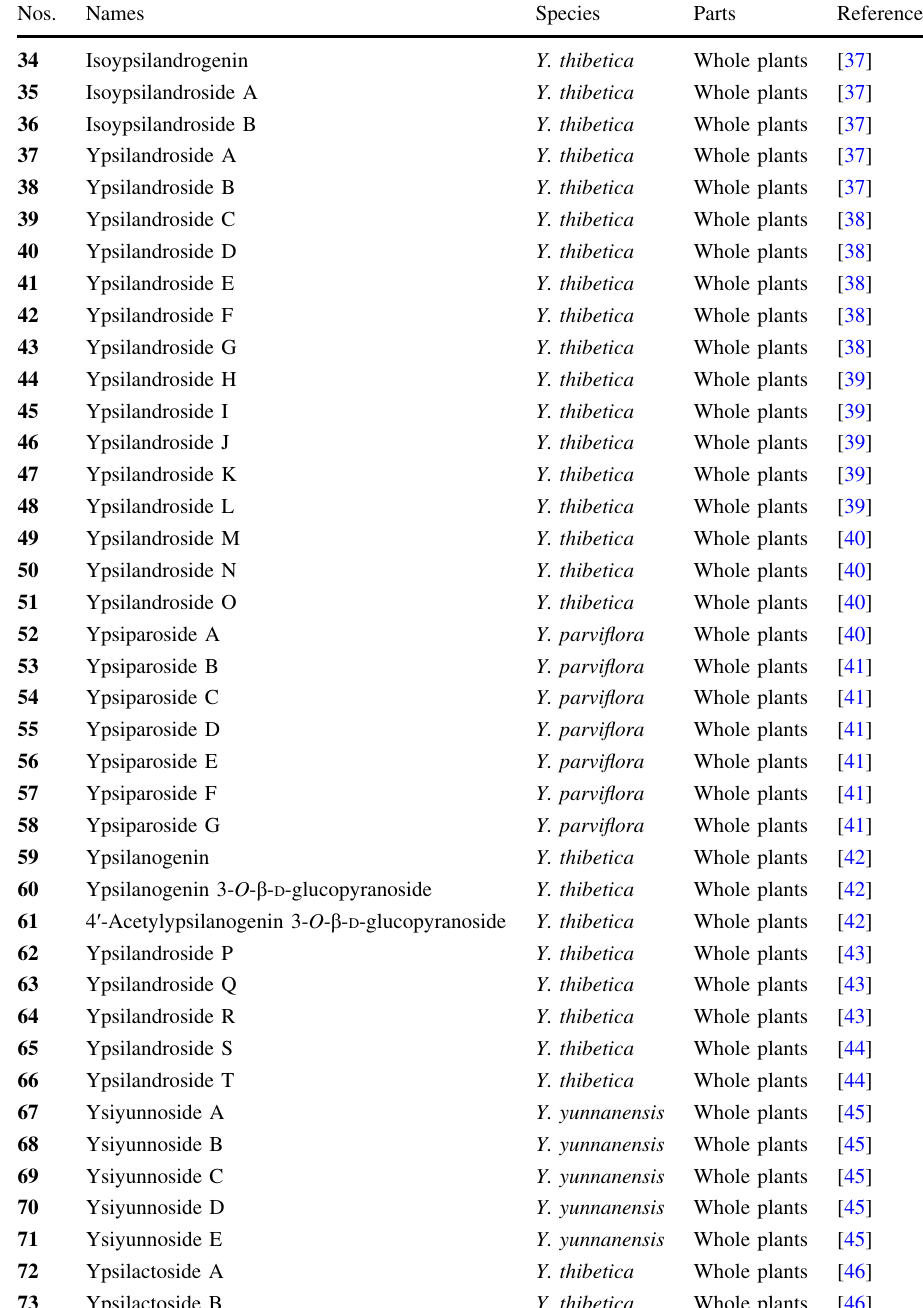
Table 2 New steroidal sapogenins and saponins from Ypsilandra species (Liliaceae)